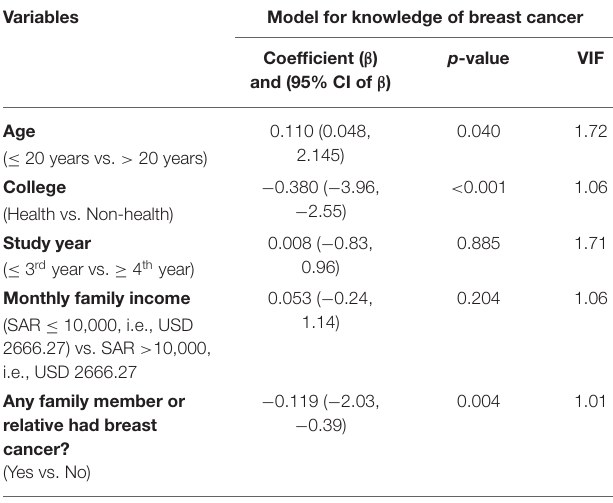
TABLE 6 | Determinants of BC knowledge ( N =